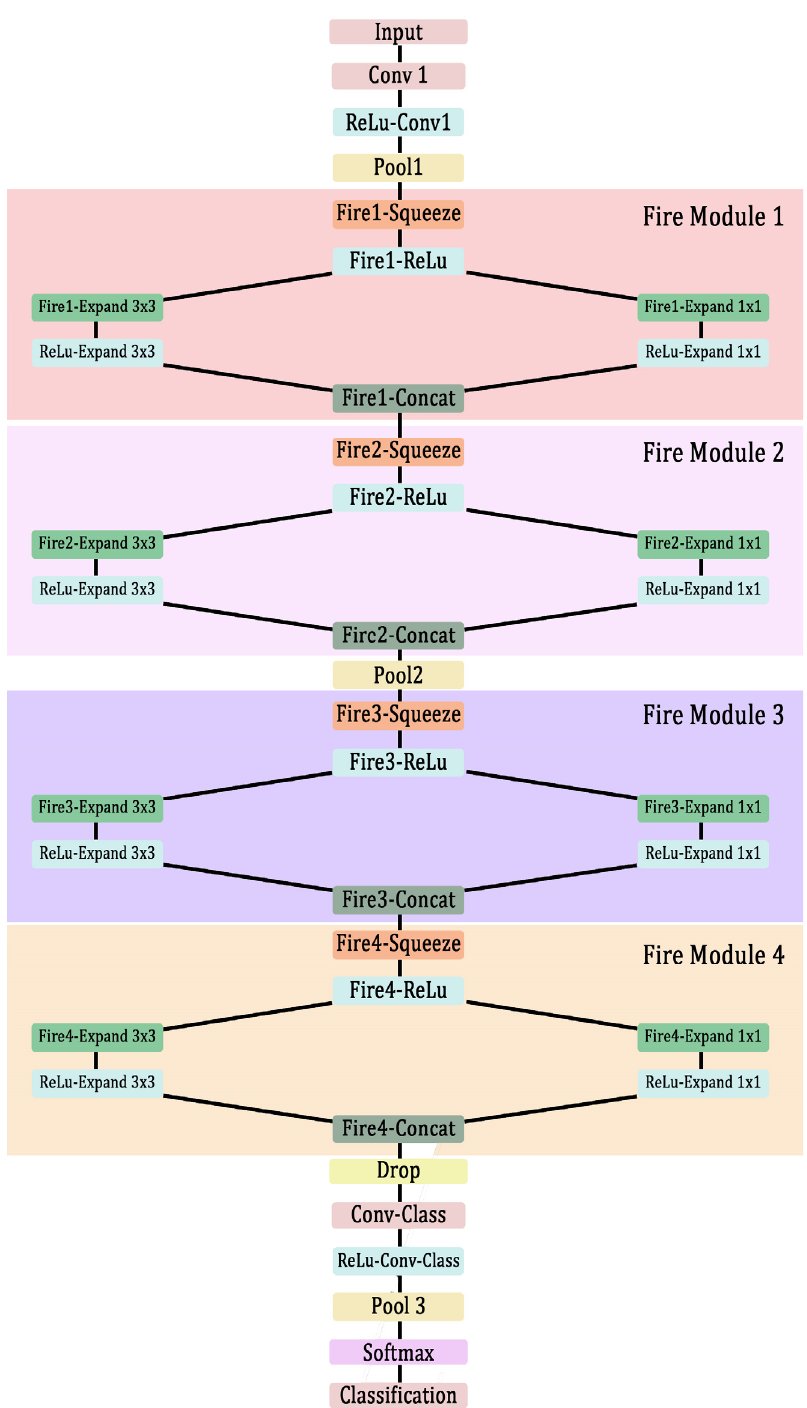
Figure 3. Architecture of the modified SqueezeNet (data flowing in one direction—from input layer to classification layer).